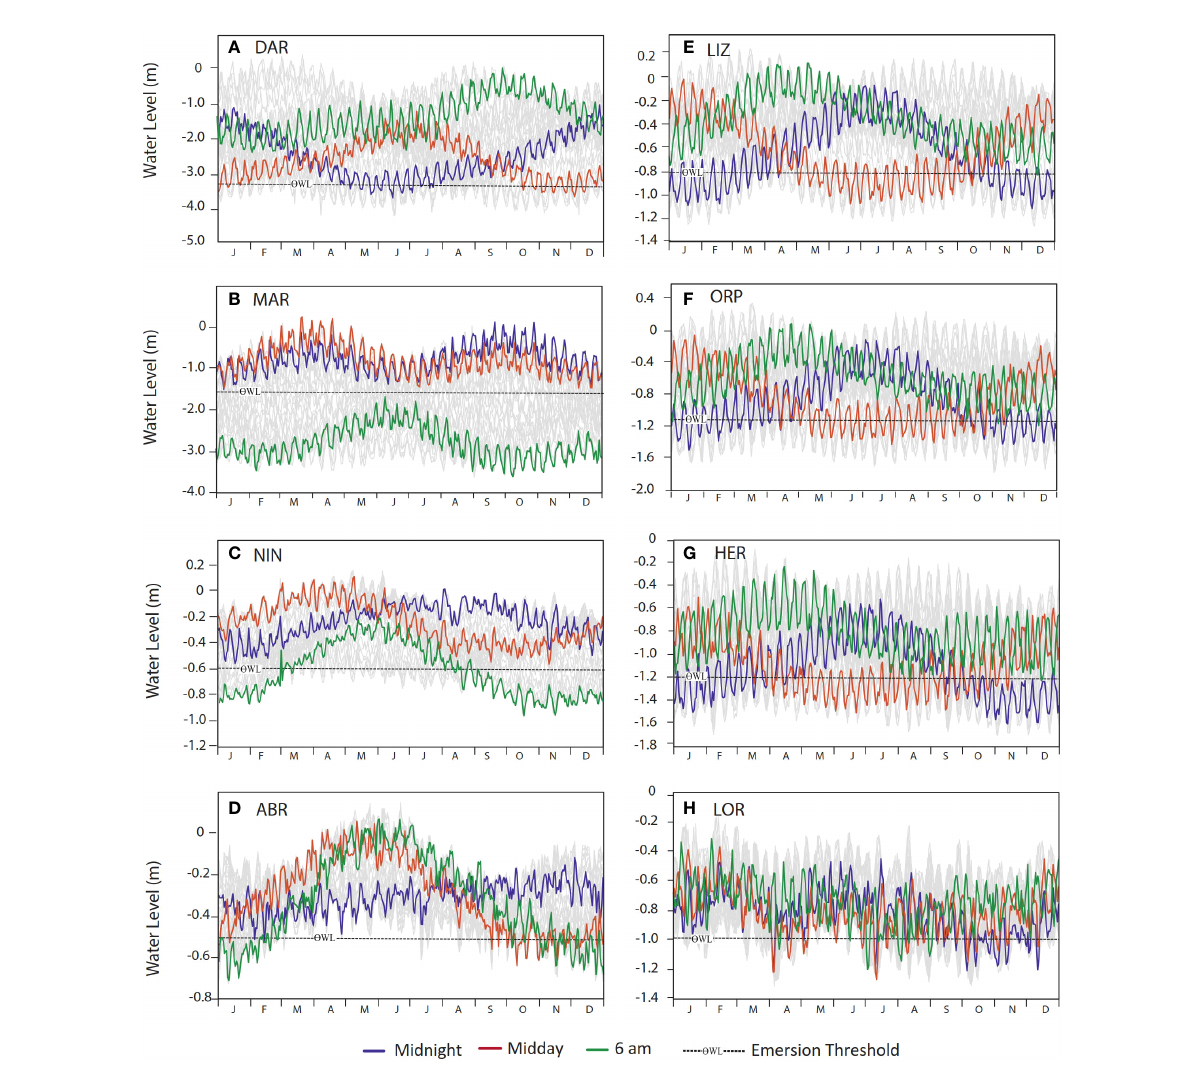
FIGURE 5 Seasonality in the daily timing of low tide for sites (A) Darwin (DAR), (B) Maret Island (MAR), (C) Ningaloo Reef (NIN), (D) Abrolhos Islands (ABR), (E) Lizard Island (LIZ), (F) Orpheus Island (ORP), (G) Heron Island (HER) and (H) Lord Howe Island (LOR), illustrated by the minimum recorded low water levels (from hourly data for each calendar day over the years1992 – 2016) for each site, highlighting minimum midday (red), midnight (blue) and 6 am (green) water levels for each day of the year. Dashed lines show emersion threshold ( Ɵ